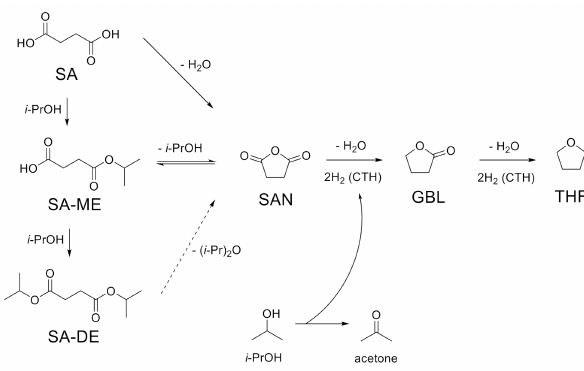
Scheme 1. Possible reaction pathway for the conversion of SA.